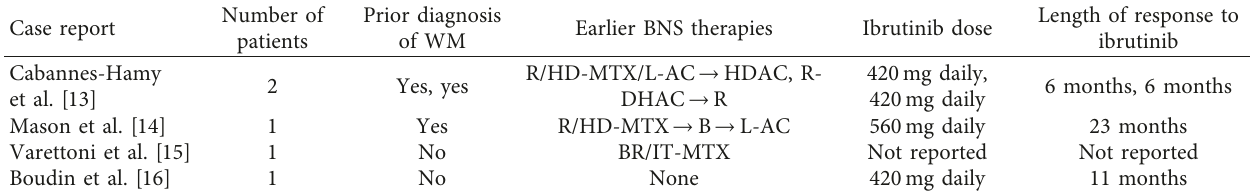
Table 1: Summary of previously reported cases of ibrutinib use for the treatment of Bing–Neel